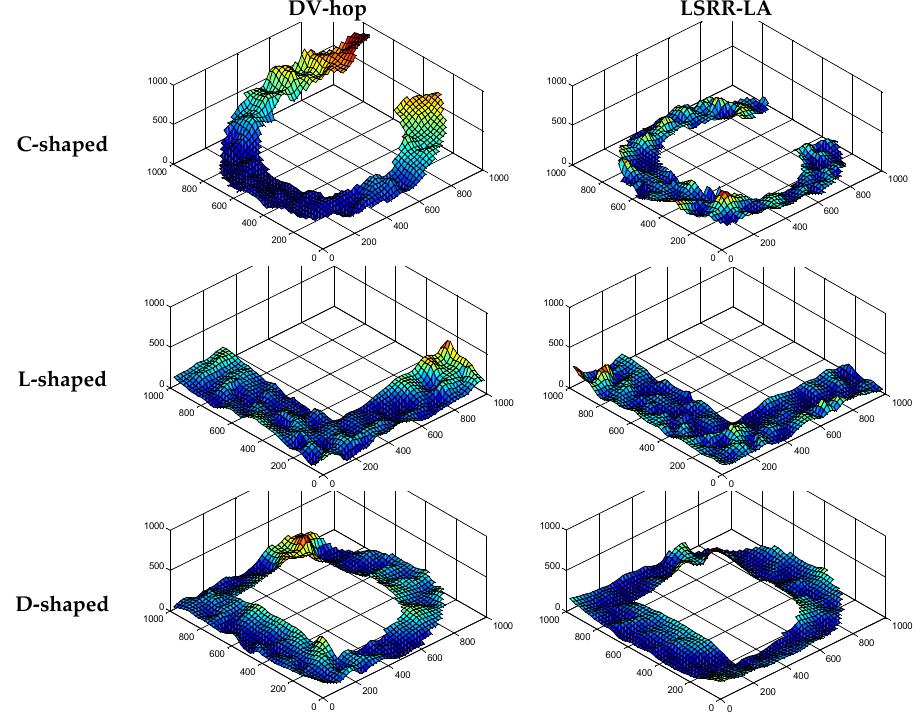
Figure 9. Comparison of 3D Localization results ( R = 150m, M = 70).